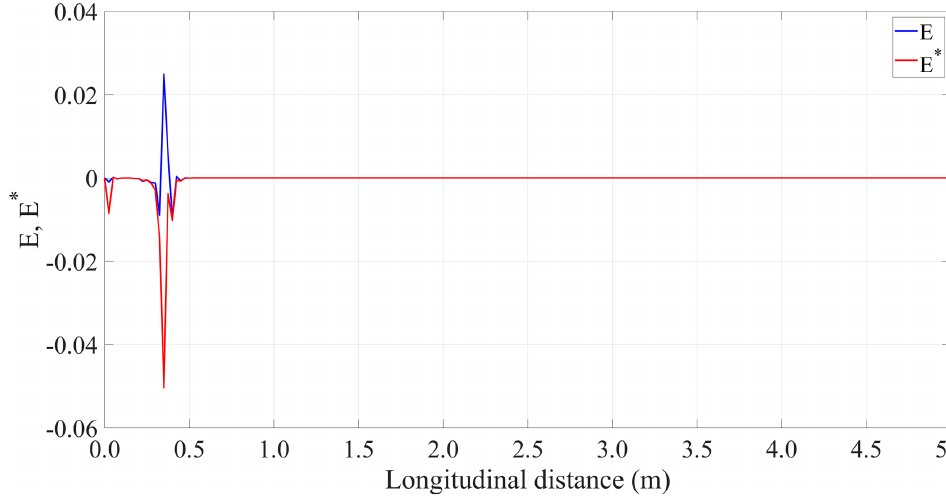
Figure 14. Test case 3: ( Top ) Comparison between the computed free surface profile and the experiment (point gauge and pressure head measurements). ( Bottom ) Numerical results for the Boussinesq term along the channel length for the MacCormack scheme, prediction and the correction step.